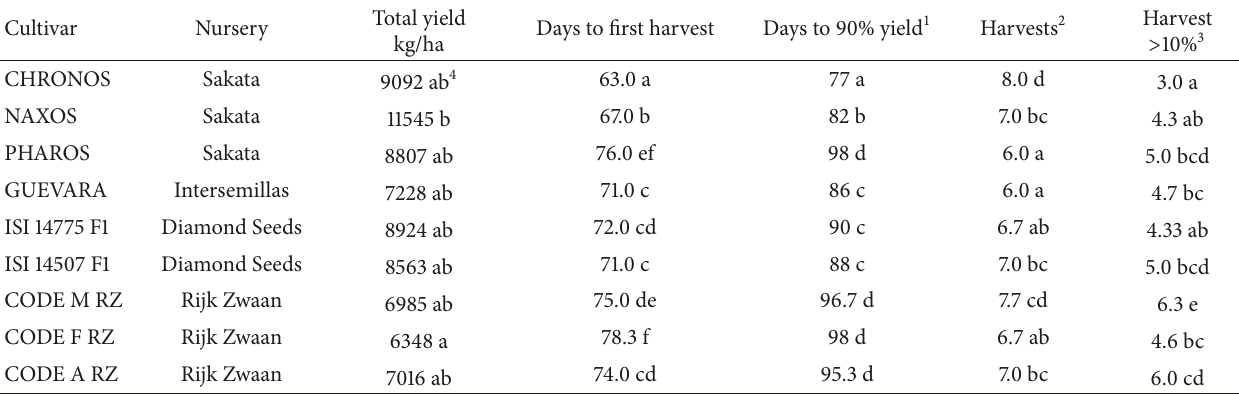
Table 1: Agronomic characteristics of broccoli cultivars from different nurseries.